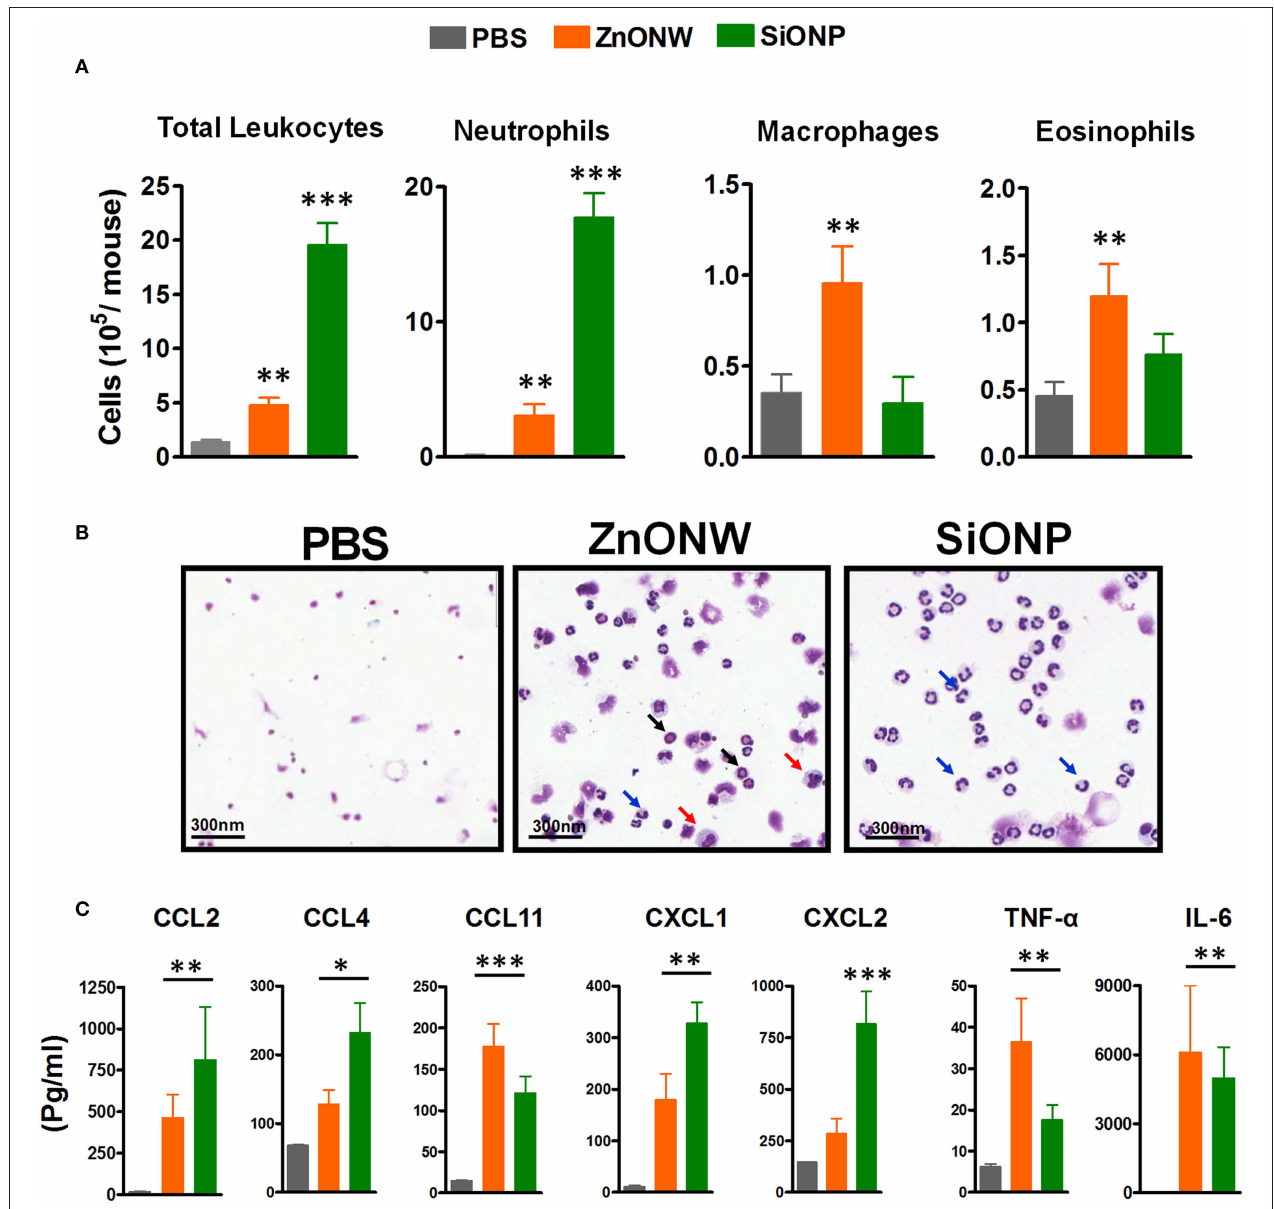
FIGURE 4 | Local inflammation induced by ZnONWs in the air pouch. Sterile air was injected s.c. on the back of the wild-type (WT) mice to form an air pouch and exposed to nanoparticles (ZnONWs or SiONP) or PBS as described in methods. Six hours post particle exposure the air pouch was lavaged with 3ml of buffer to assess infiltrating immune cells. The total number of leukocytes and differential count for cell types recruited in the air-pouch are indicated. Data are representative of at least five mice per group (A) . Cytospin slides showing macrophage (red arrow), neutrophils (blue arrow), and eosinophils (black arrow) (B) . Cytokines and chemokines were analyzed in air-pouch lavage from PBS or particles treated mice using Multiplex analysis. Levels of inflammatory proteins IL-6, TNF- α , CCL2, CCL4, CCL11, CXCL1, and CXCL2 are shown (C) . Data represent at least five mice per group; error bars denote mean ± SEM. * P < 0.03, ** P < 0.009, *** P < 0.0007; Unpaired t